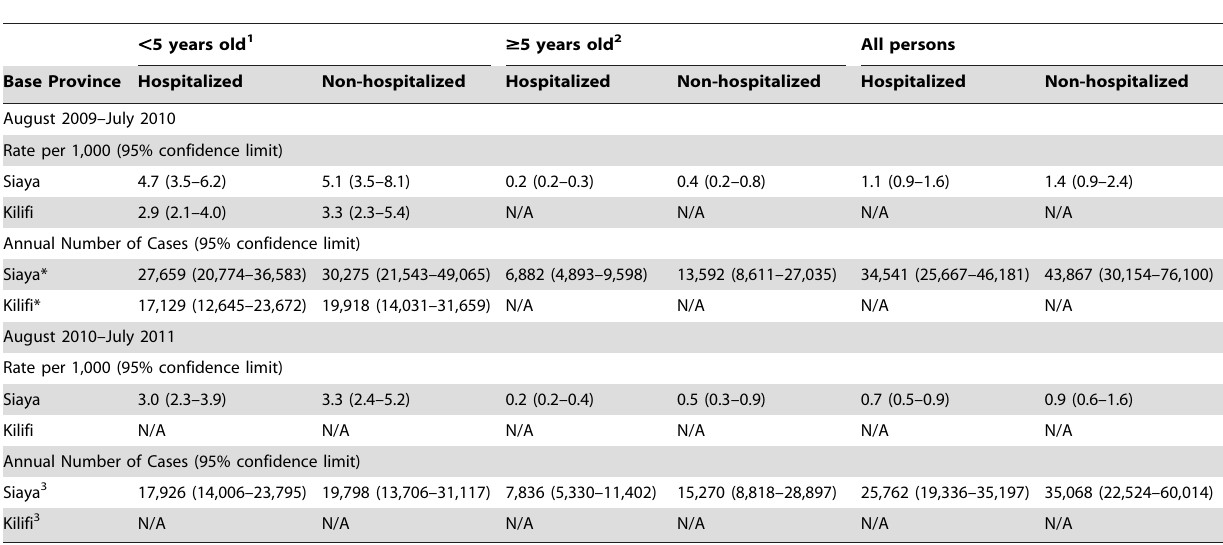
Table 4. National average annual rate (per 1,000 persons) and number of cases (and 95% Confidence Limits) of Influenza- Associated SARI in Kenya, August 2009 to July